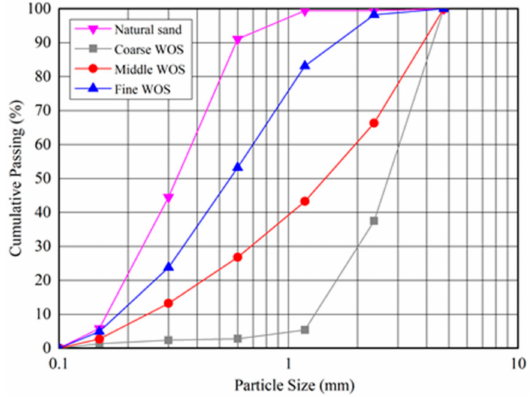
Figure 2. The particle size distributions of aggregates.